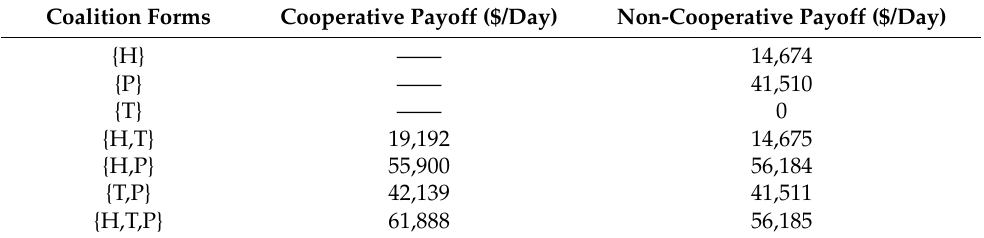
Table 2. Dispatching results of cooperative and non-cooperative